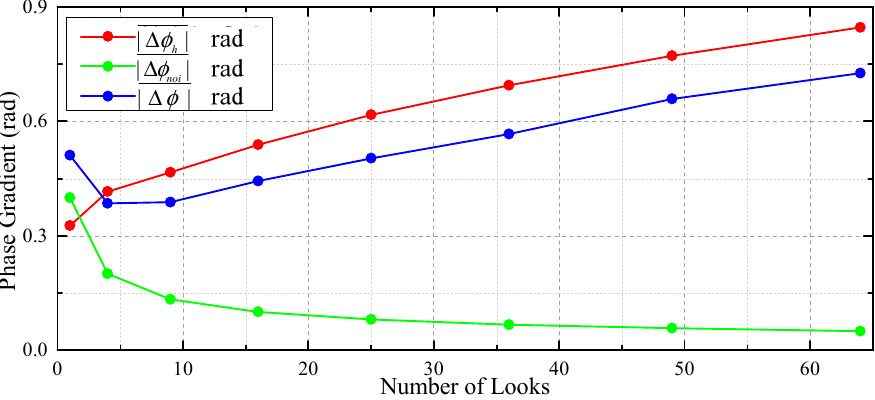
Figure 6. Relationship between number of looks and the mean values of absolute height phase gradient, absolute noise phase gradient, and absolute phase gradient.